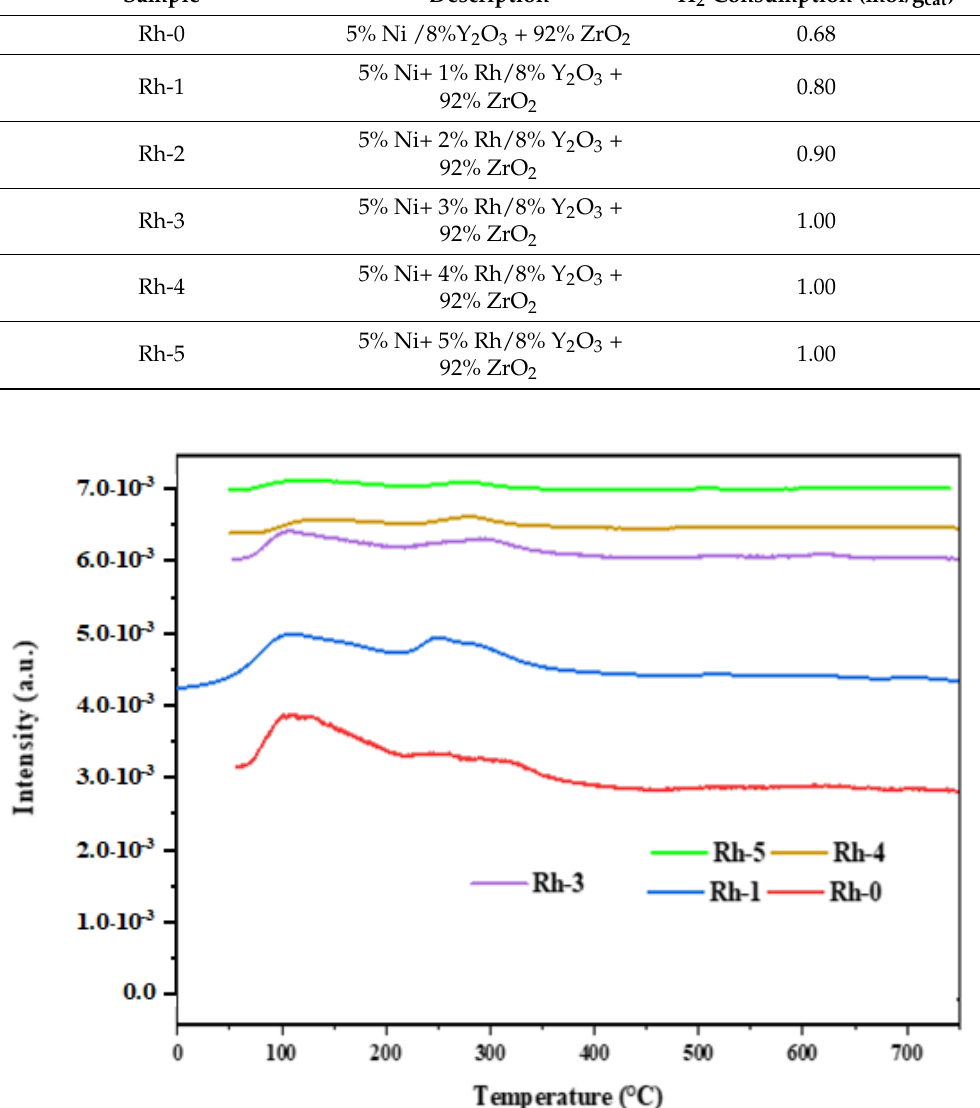
Figure 4. CO 2 -TPD profiles for Ni- Rh-x (x = 0, 1, 3, 4, 5 wt.%) catalysts. Table 3. H 2 consumption for promoted Rh 2 O 3 catalysts.